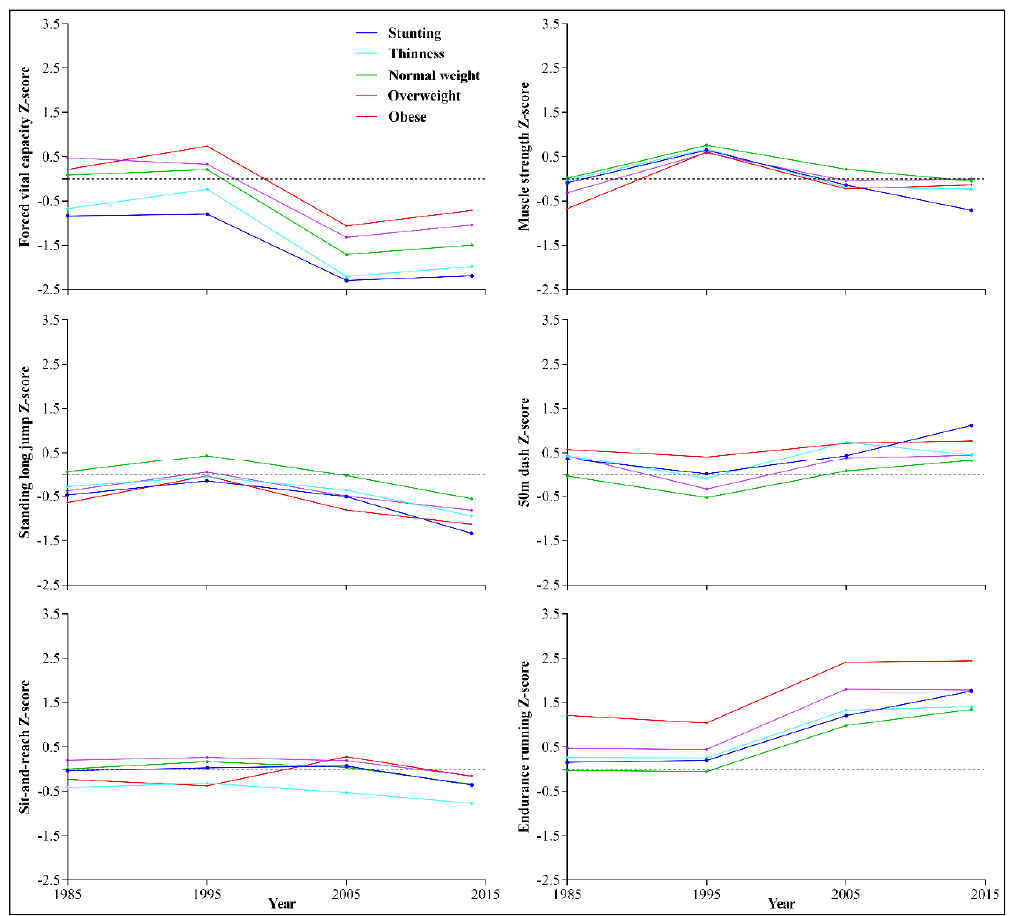
Figure 5. Trends in the six core items of physical fitness among girls in Xinjiang with different nutritional status, 1985 to 2014.